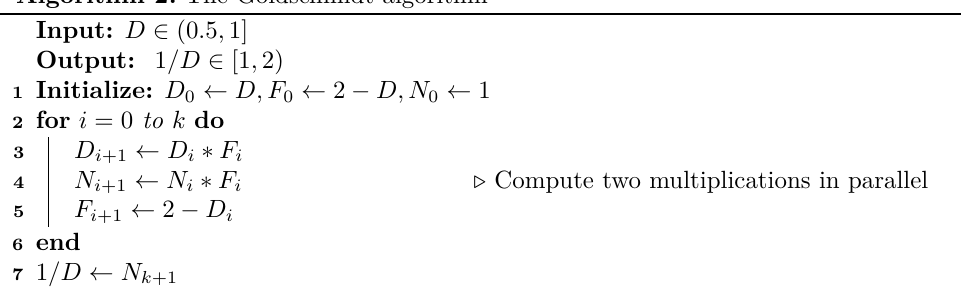
Algorithm 2: The Goldschmidt